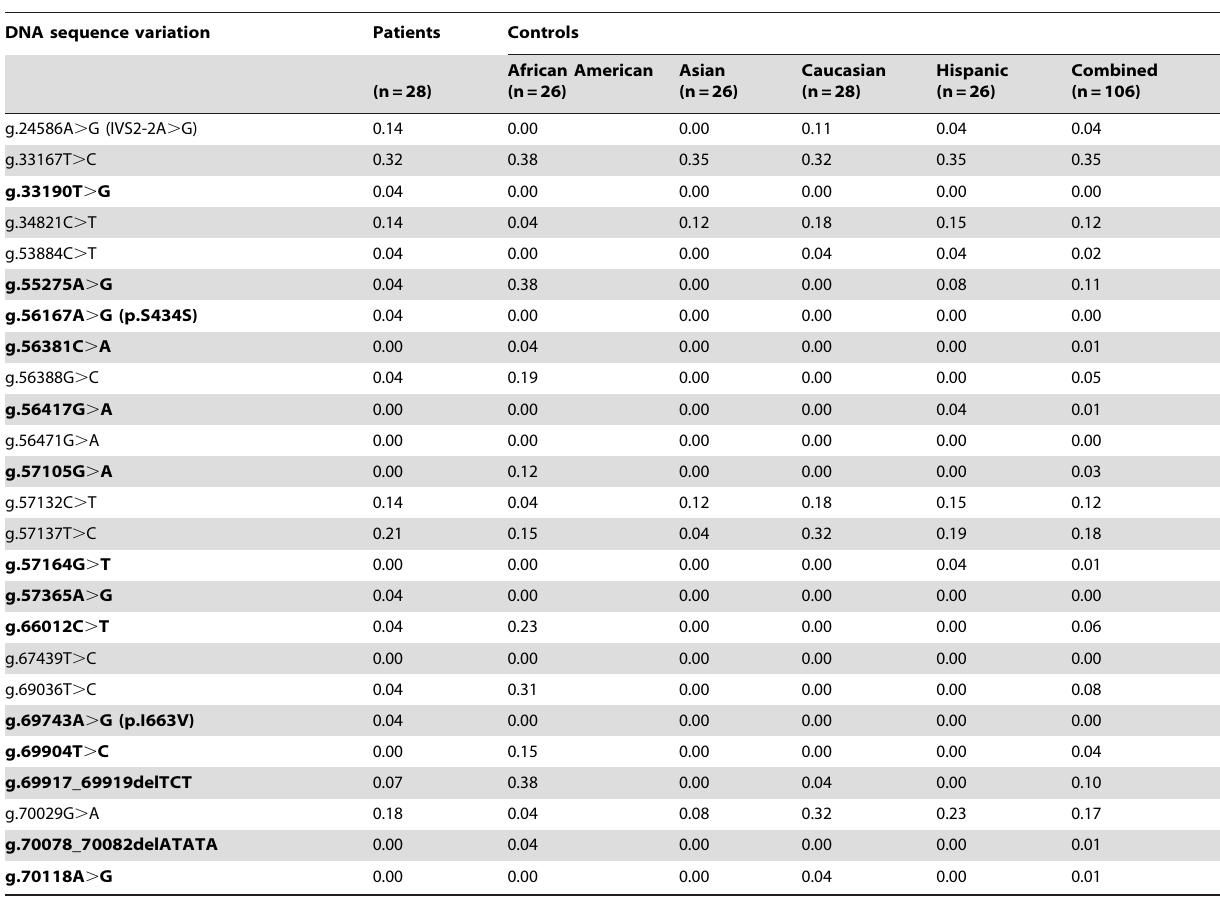
Table 3. Heterozygosity of sequence variations in SLC26A5.